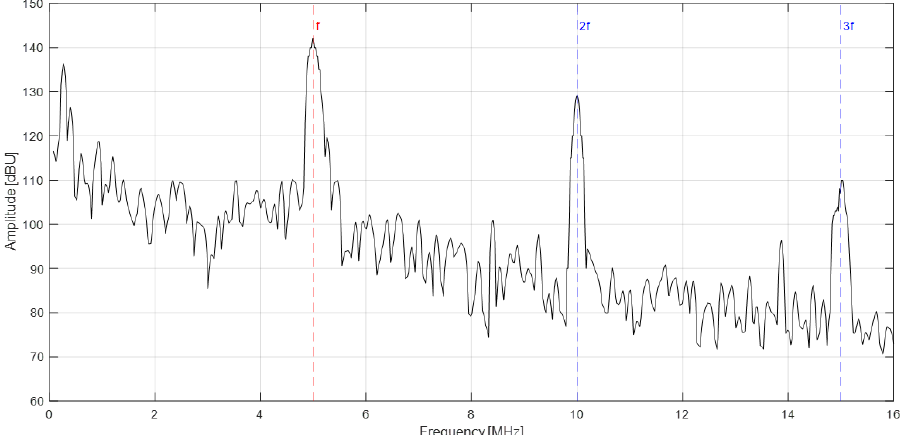
Figure 4. Quasi-one-dimensional frequency spectrum, LS-DYNA simulation with excitation frequency f = 5 MHz.